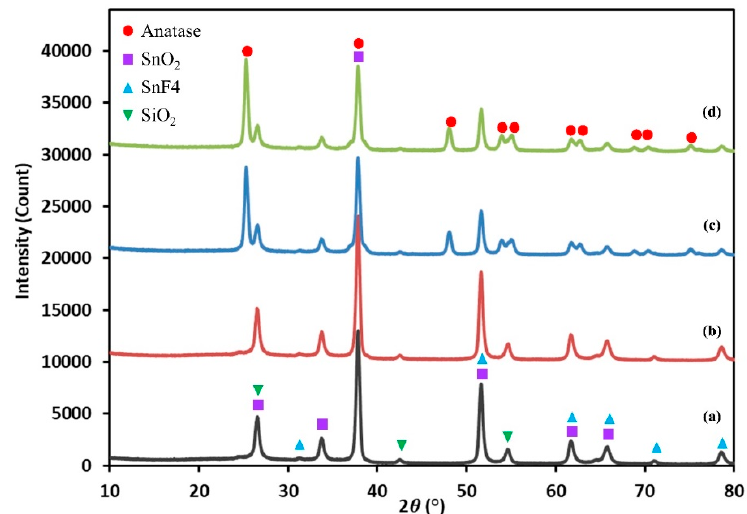
Figure 5. X-ray diffraction (XRD) spectrum of ( a ) FTO substrate, ( b ) FTO substrate treated with TiCl 4 , ( c ) TiO 2 film on FTO substrate, and ( d ) TiO 2 film on FTO substrate after treatment with TiCl 4.